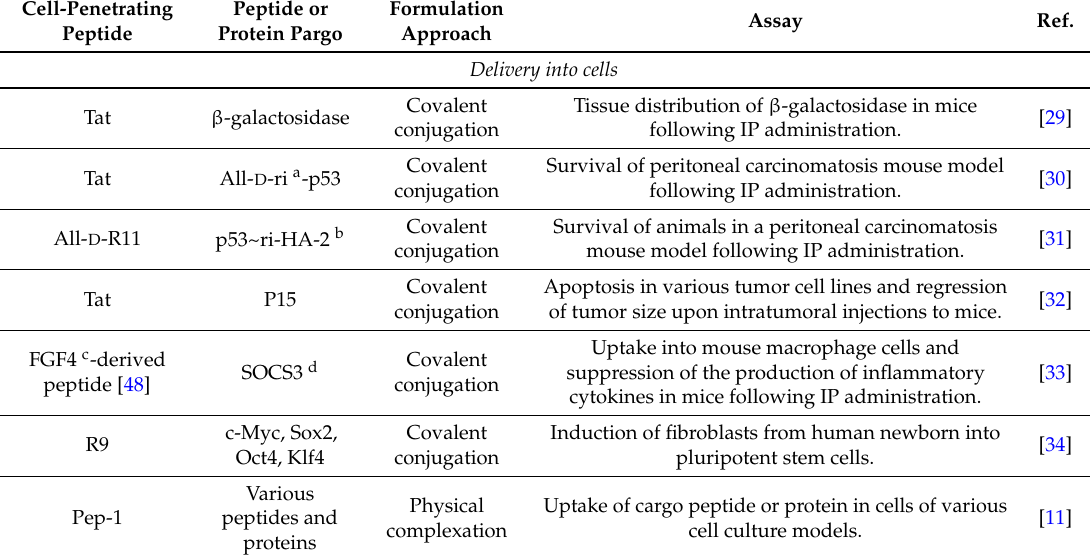
Table 1. Selected peptide and protein cargos delivered by cell-penetrating peptides highlighting the formulation approach applied and the assays employed for studying tissue distribution or for verification of